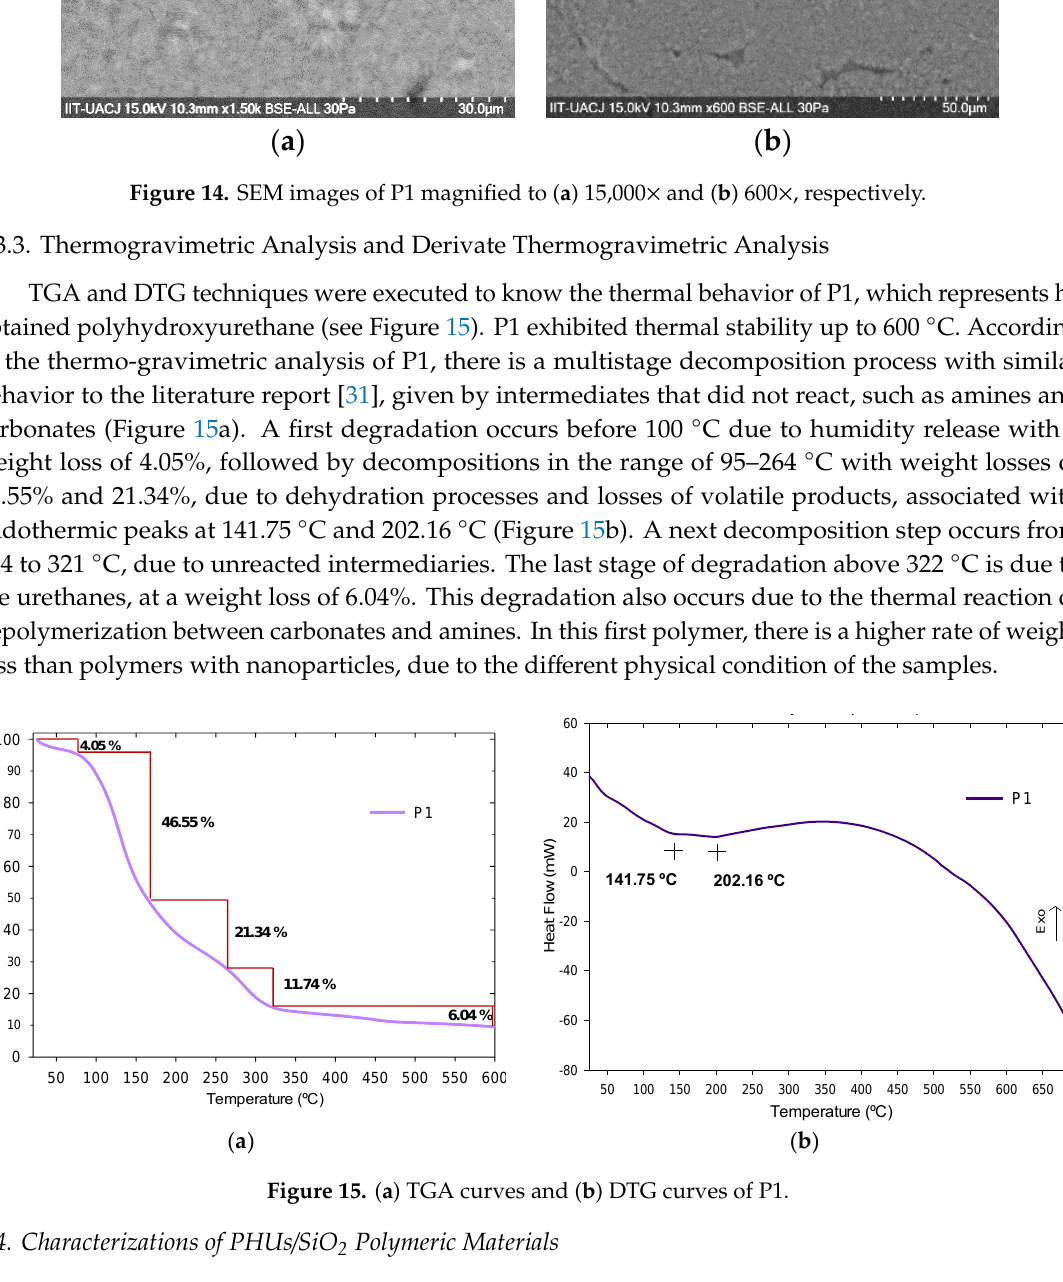
Figure 15. ( a ) TGA curves and ( b ) DTG curves of P1.